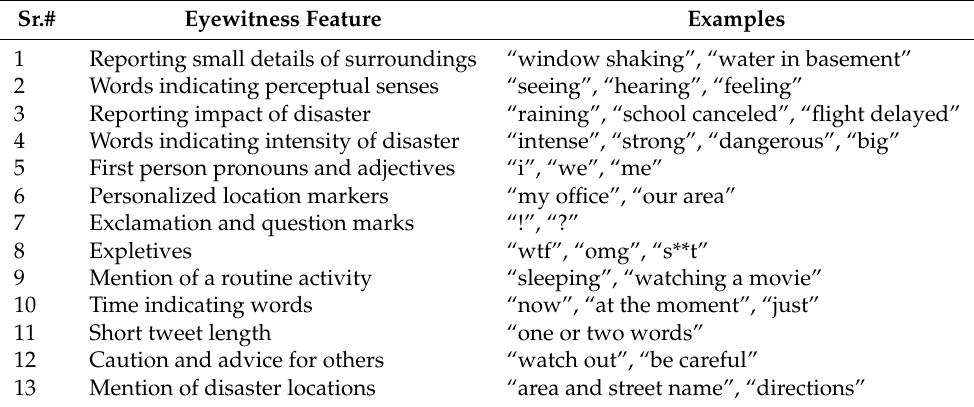
Table 1. Characteristics for Eyewitness Identification (Zahra et al.